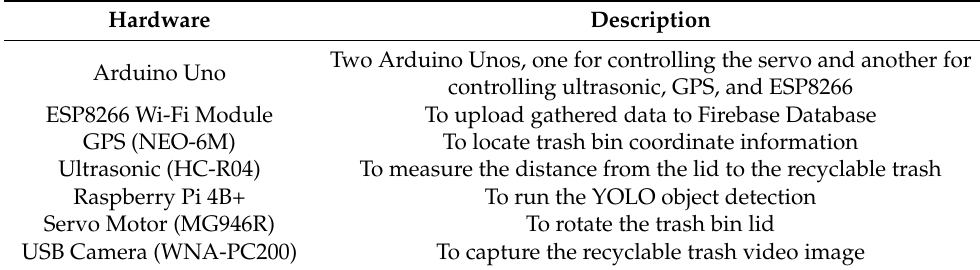
Table 1. Hardware